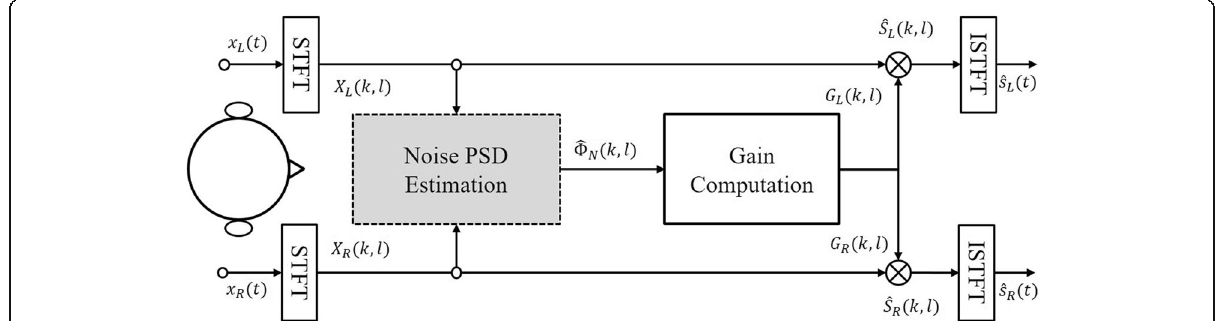
Fig. 1 Block diagram of the binaural speech enhancement